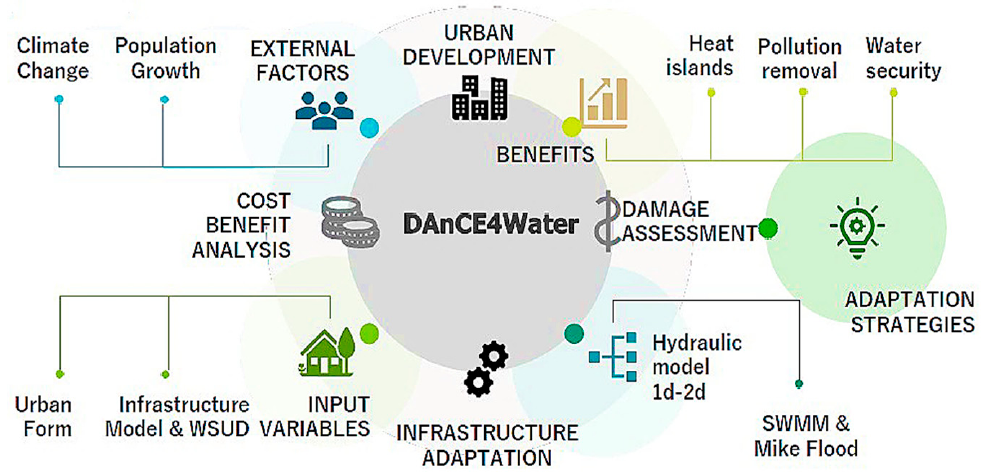
Figure 5. DAnCE4Water module (Adapted with permission from ref. [41] 2021 Elsevier).